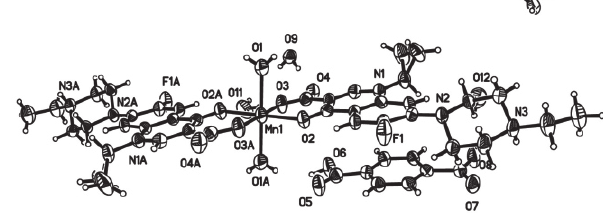
try defined by two bidentate O,O' -bonded 1-cyclopropyl-7-(4- ethylpiperazin-1-yl)-6-fluor-4-oxo-1,4-dihydrochinolin-3- carboxylate ( Henro ) zwitterions and two water molecules. There is a benzene-1-carboxyl-4-carboxylate (1,4- bdc ) anion fore the